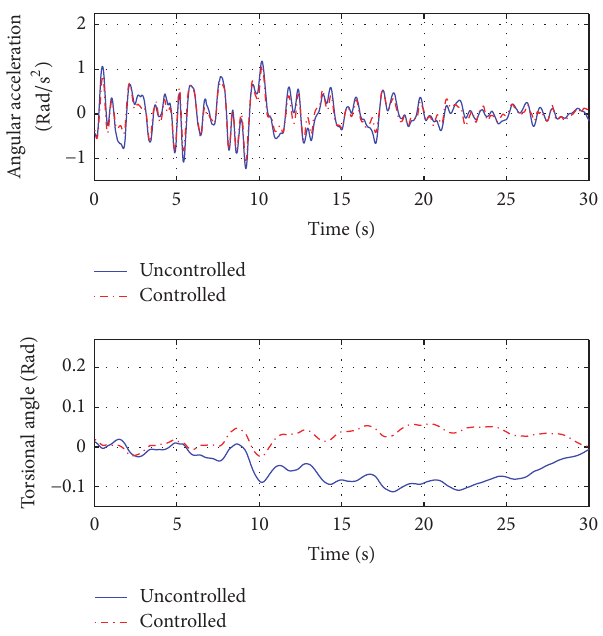
Figure 18: Torsional response of the tower top under earthquake.